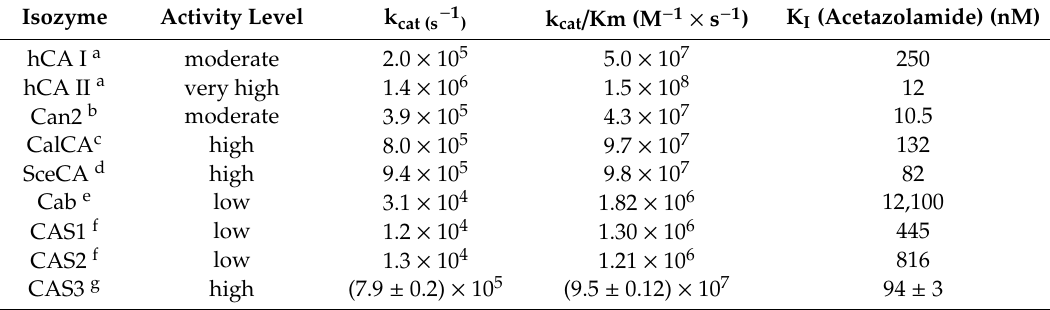
Figure 2. Active site architecture of a generic β‐ CA: ( A ) a closed ‐ active site enzyme [45–47] with the zinc ion ( magenta sphere ) coordinated by a His residue ( in blue ), two Cys residues ( in green ) and an Asp residue of the catalytic dyad ( in red ). ( B ) Open active site. The His and Cys residues remain coordinated to the Zn(II) ion whereas the Asp makes a pH dependent salt bridge interaction with the Arg of the dyad. Thus, the fourth coordination position of Zn(II) will be occupied by a water molecule ( not shown ). In the case of CAS3, Cys41, His93 and Cys96, the residues are shown in panels A and B, and the Asp43 in panel A is coordinated to the Zn(II) ion or forms a salt bridge with Arg45 in panel B. Thus, we investigated the CO 2 hydrase activity of CAS3 and compared it to that of other α‐ and β‐ class enzymes, as shown in Table 1. Table 1. Kinetic parameters for the CO 2 hydration reaction [44] catalyzed by the three CAS enzymes. CAS1 ‐ CAS3, the human cytosolic isozymes hCA I and II ( α‐ class CAs) at 20 °C and pH 7.5 in 10 mM HEPES buffer (for the α‐ CAs), as well as Can2 (from C. neoformans ), CalCA (from C. albicans ), SceCA (from S. cerevisiae ) and Cab (from the archaeon Methanobacterium thermoautotrophicum ) measured at 20 °C, pH 8.3 in 20 mM TRIS buffer and 20 mM NaClO 4 . (for all β‐ CAs). Inhibition data with the clinically used sulfonamide acetazolamide (5-acetamido-1,3,4-thiadiazole-2-sulfonamide) are also